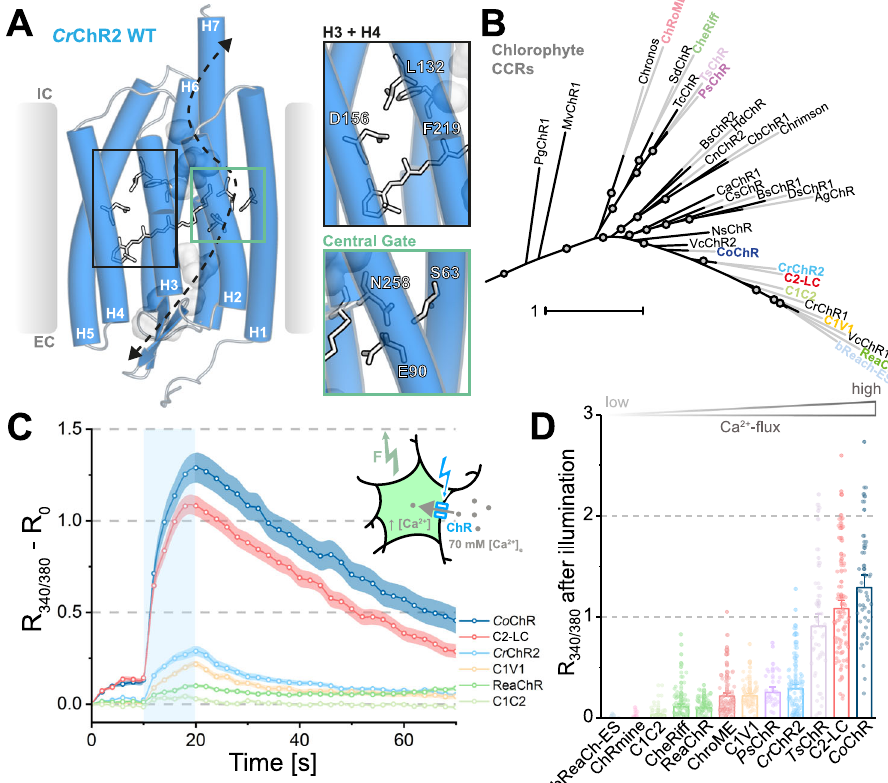
Fig. 1 | Calcium fl ux at high [Ca 2+ ] e in selected CCRs. A Cr ChR2 crystal structure (PDB ID: 6EID, https://doi.org/10.2210/pdb6EID/pdb) with proposed ion permea- tion pathway (black arrow) and water densities after 10ns MD simulation (grey mesh). Amino acids in stick representation have been previously associated with calciumpermeation.Insets,right:H3andH4)Helix3andHelix4withresiduesL132, D156 and F219 (Helix 6) and Central Gate) Central Gate formed by S63, E90 and N258. B Unrooted phylogenetic tree of chlorophyte CCRs. Coloured entries represent ChRs with calcium measurements in panels ( C ) and ( D ). Overview of depicted CCRs can be found in Supplementary Fig. 1. C Fura-2 imaging of calcium